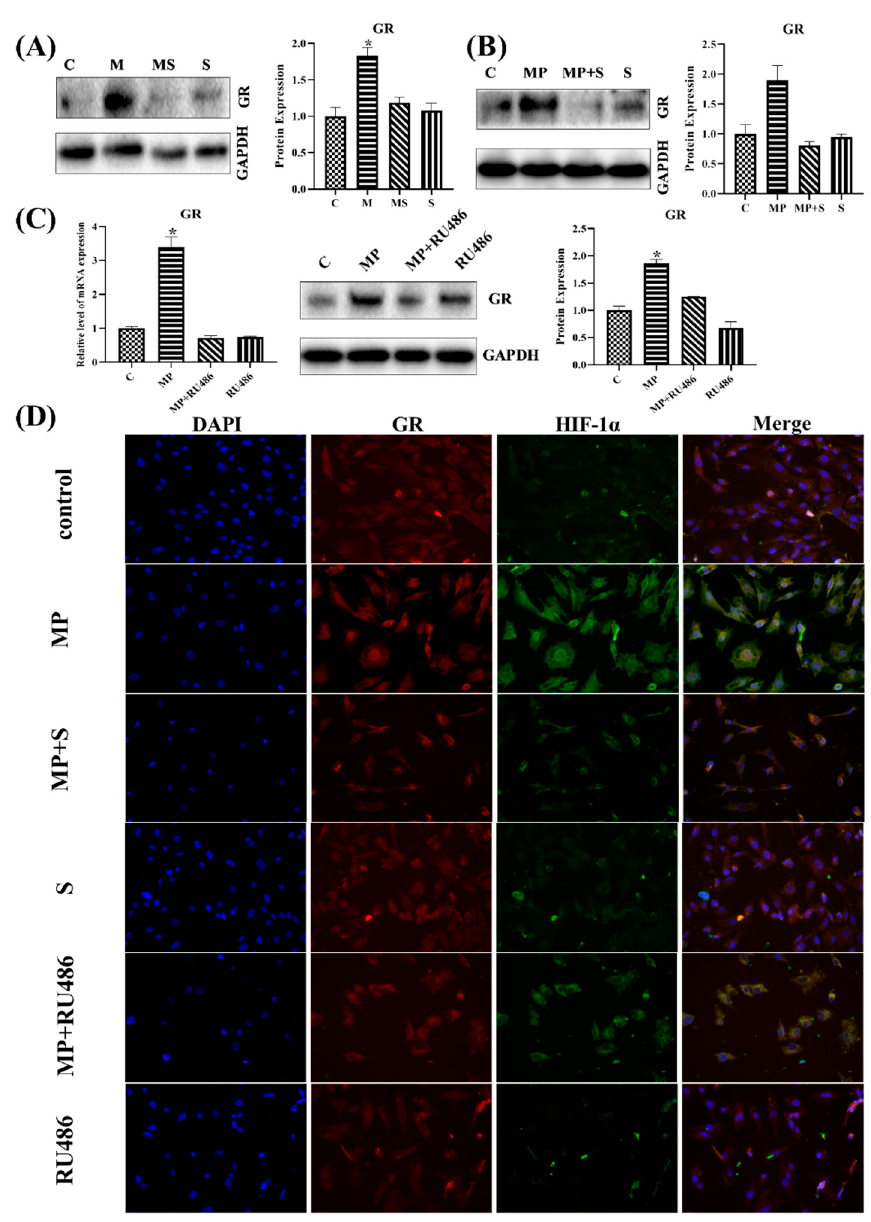
Figure 7. The GR expressions with different treatments. ( A ) The 56 d protein expressions of GR in articular cartilage. ( B ) The protein expressions of GR in chondrocytes. ( C ) The mRNA and protein expressions of GR in chondrocytes with RU486-treatment. ( D ) Immunocytofluorescence staining of GR (red) and HIF-1 α (green) in chondrocytes with different treatments (400 × ). Here, * p < 0.05 vs. control